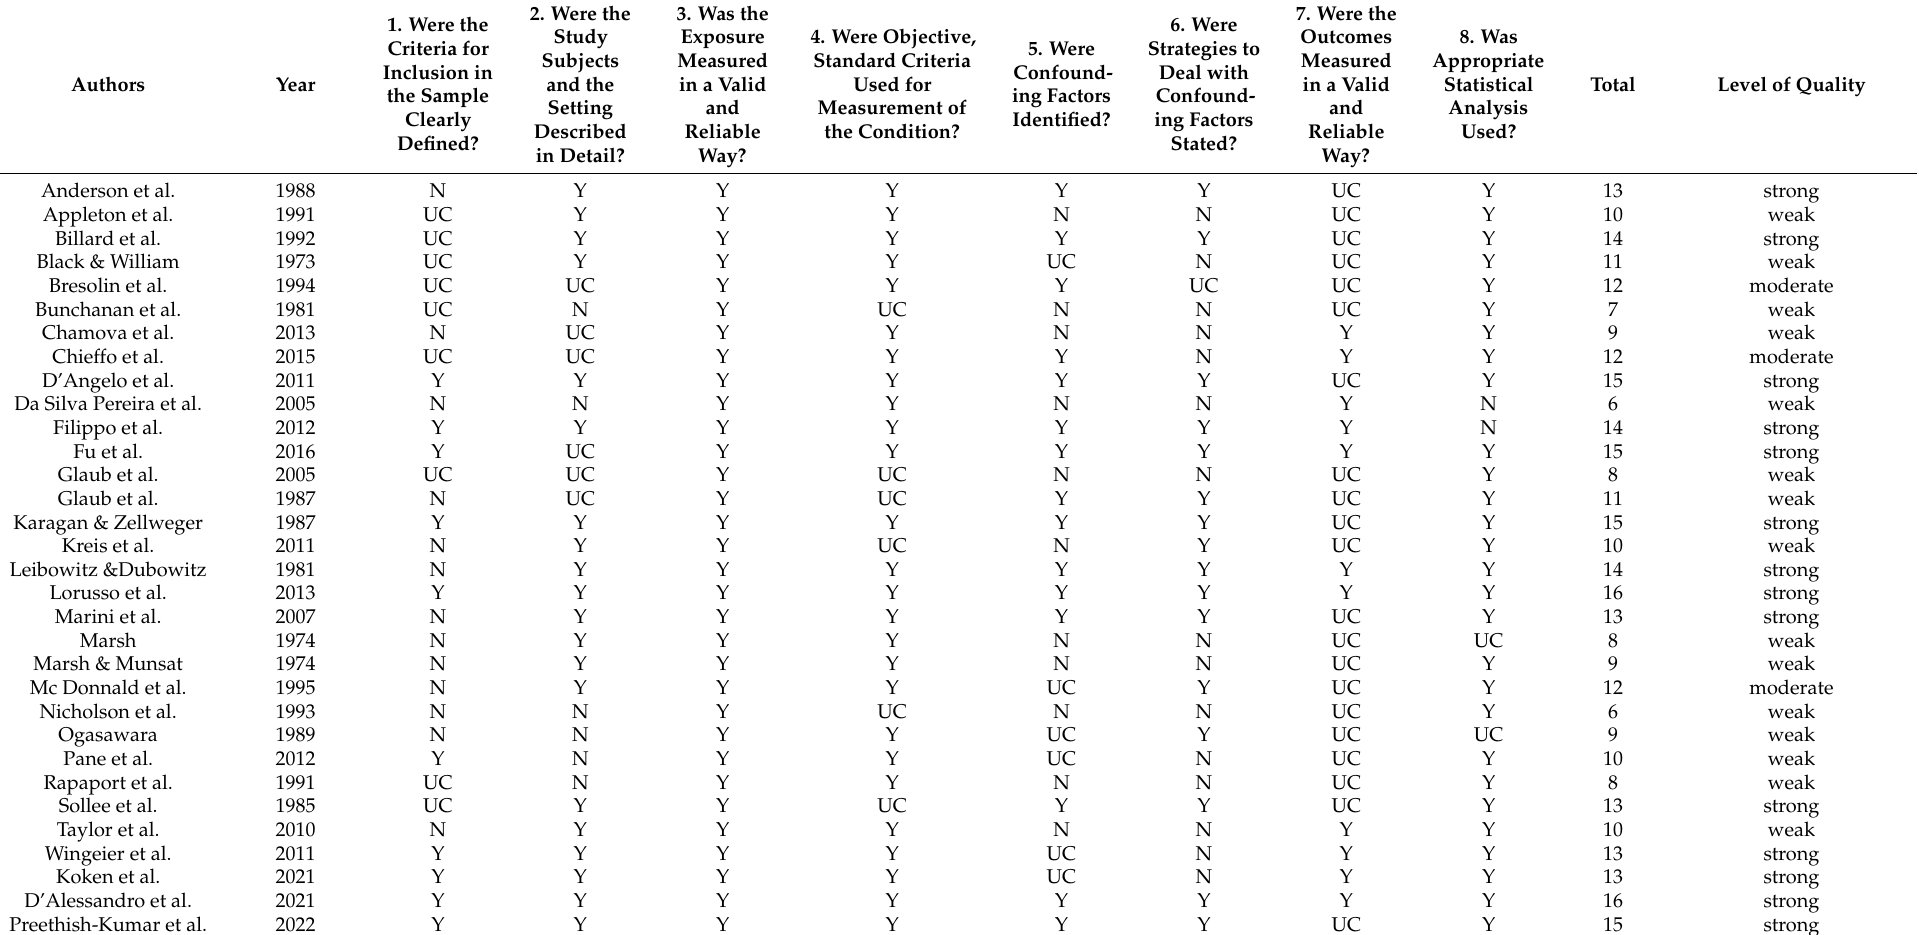
Table A1. Quality of evidence of the DMD